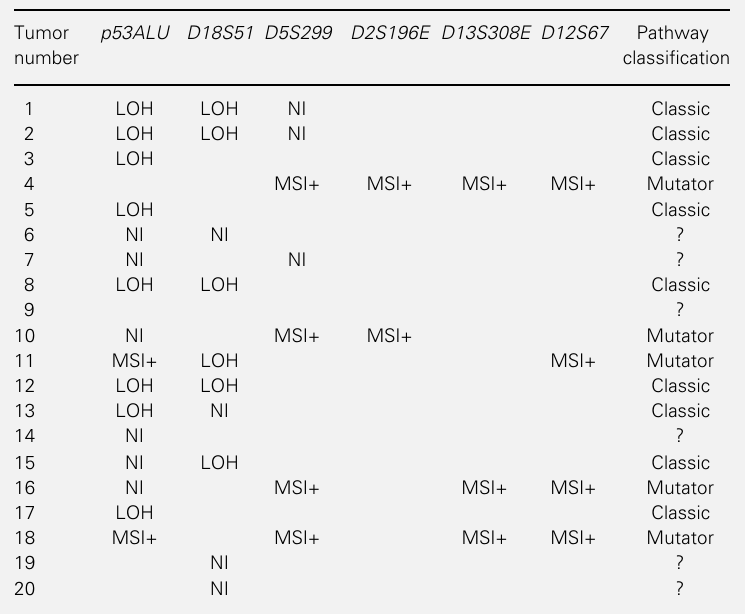
Table 2 - Microsatellite findings in each of the 20 colorectal tumors studied. LOH = Loss of heterozygosity; NI = not informative (only indicated for the p53ALU , D18S51 and D5S299 ); MSI+ = microsatellite instability present.